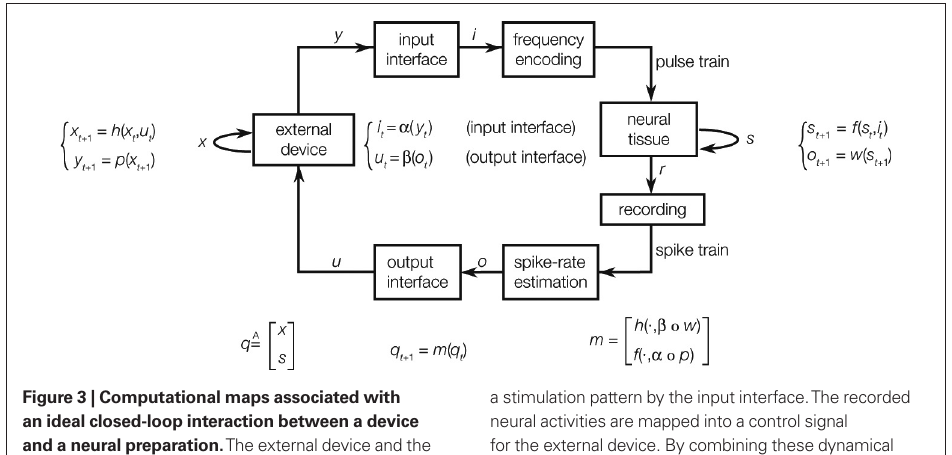
Figure 3 | Computational maps associated with an ideal closed-loop interaction between a device and a neural preparation. The external device and the neural tissue dynamics are described by a state equation, yielding the next state as a function of the current state and the input. The output of the device is mapped into